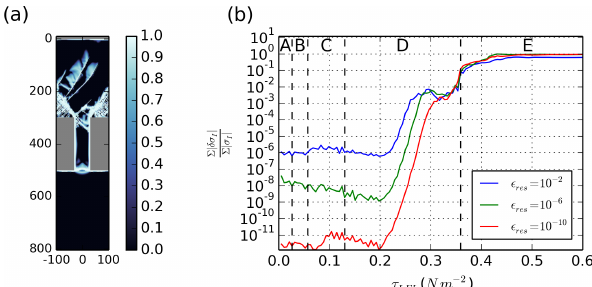
Figure 14. (a) Asymmetries dominating the damage fields after the ice bridge collapse (Stage E) in Fig. 4. (b) Evolution of normalized, domain-integrated asymmetries in the σ I field when using different residual tolerance (cid:15) res on the solution. Dashed lines indicate the beginning and end of the simulation phases (A, B, C, D,